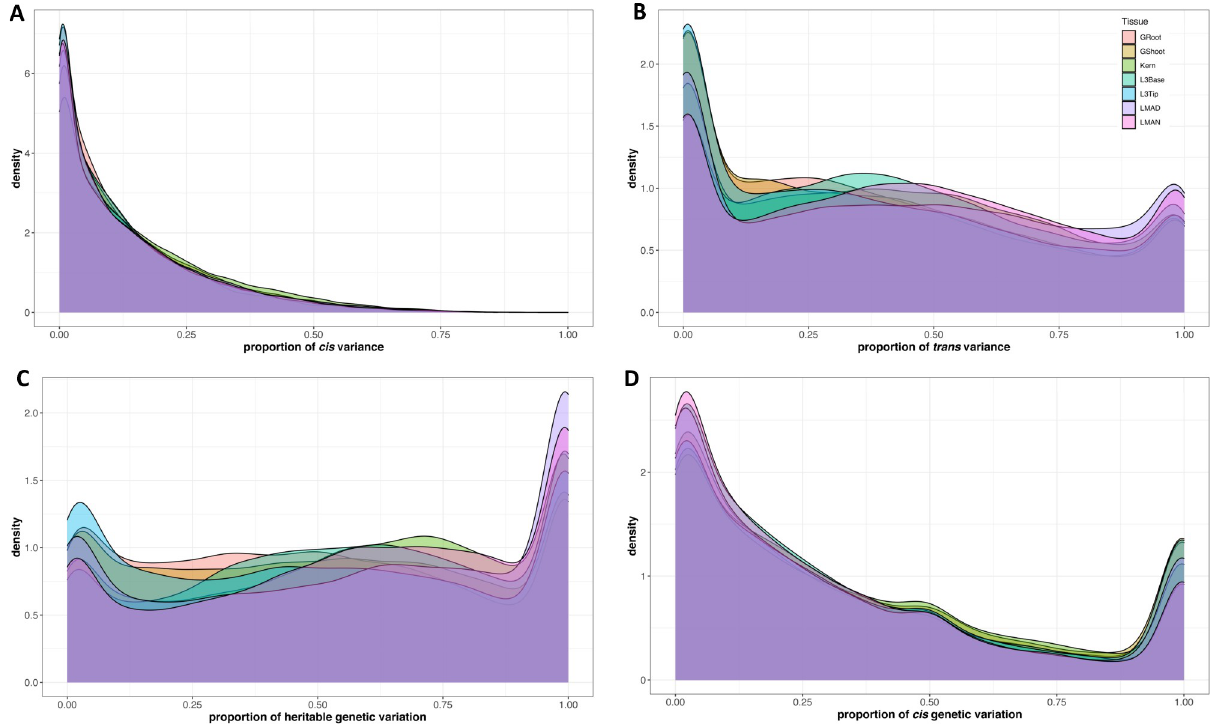
Fig 2. Cis haplotype explained one-third of the total genetic variance in expression. Proportion of variation explained by (A) cis and (B) trans components, (C) Proportion of heritable genetic variation over phenotypic variation and (D) proportion of heritable genetic variation explained by cis in gene expression across 7 different tissues. Heritable variation was calculated in each gene as the ratio of the sum of cis and trans variance to total variance. Different colors represent 7 diverse tissues in maize: germinating seedlings root (GRoot), germinating seedlings shoot (GShoot), 2 cm from the base of leaf 3 (L3Base), 2 cm from the tip of leaf 3 (L3Tip), mature mid-leaf tissue sampled during mid-day (LMAD), mature mid-leaf tissue sampled during mid-night (LMAN), and developing kernels harvested after 350 growing degree days after pollination